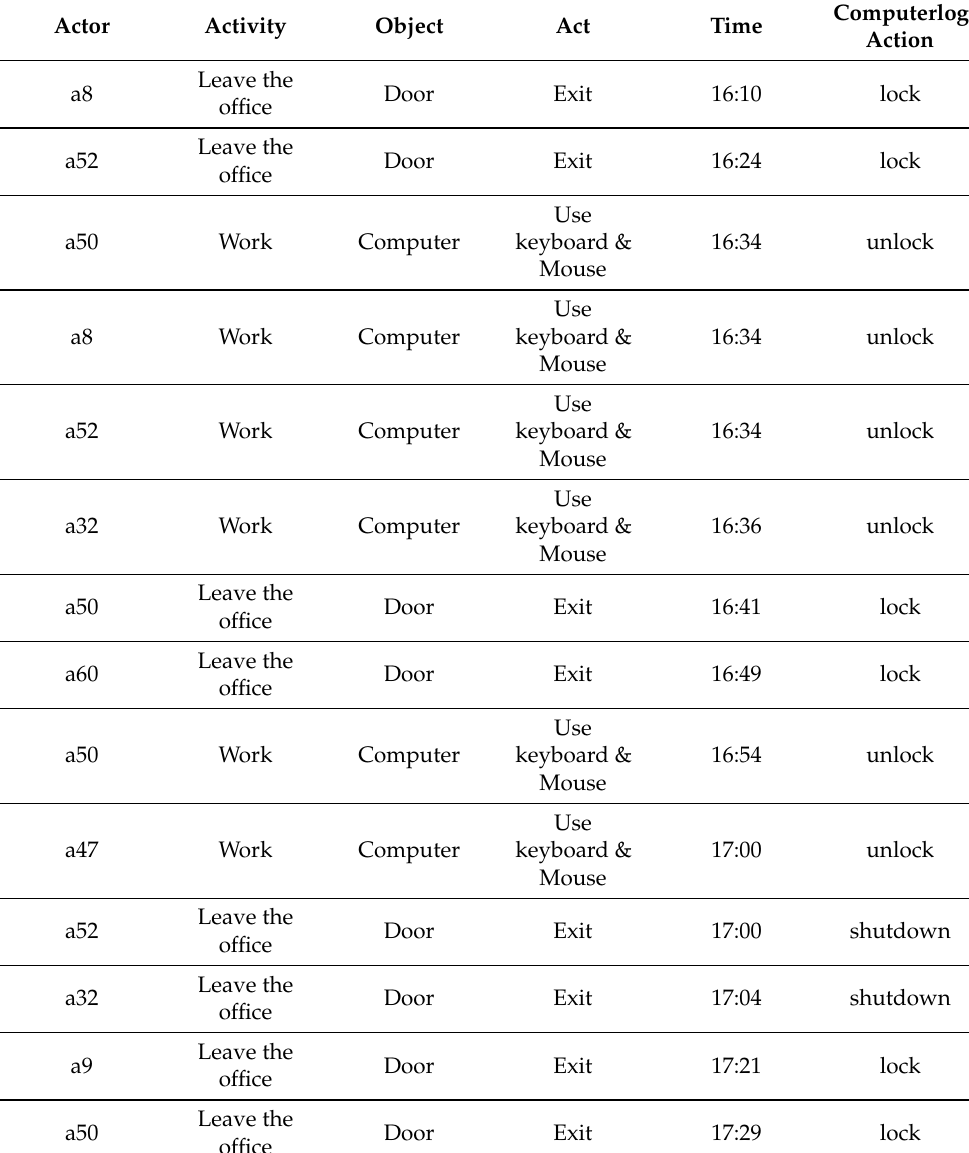
Table 6. Observation table with computer log action